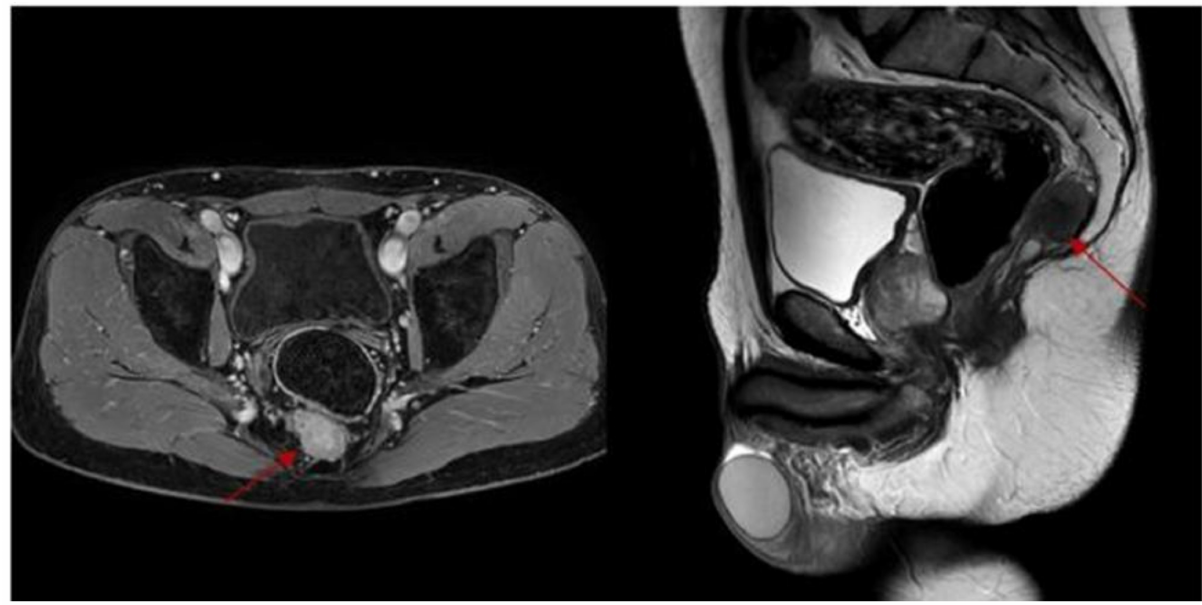
Figure 1. Magnetic resonance imaging shows the tailgut cyst in the presacral space below